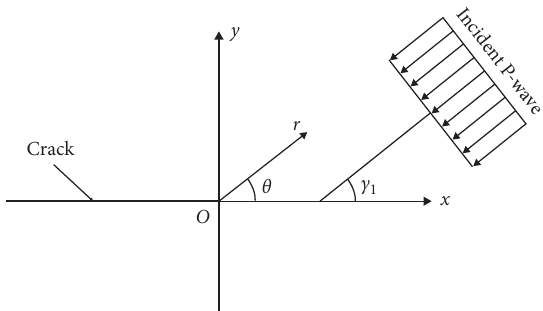
Figure 1: Interaction between P-wave and